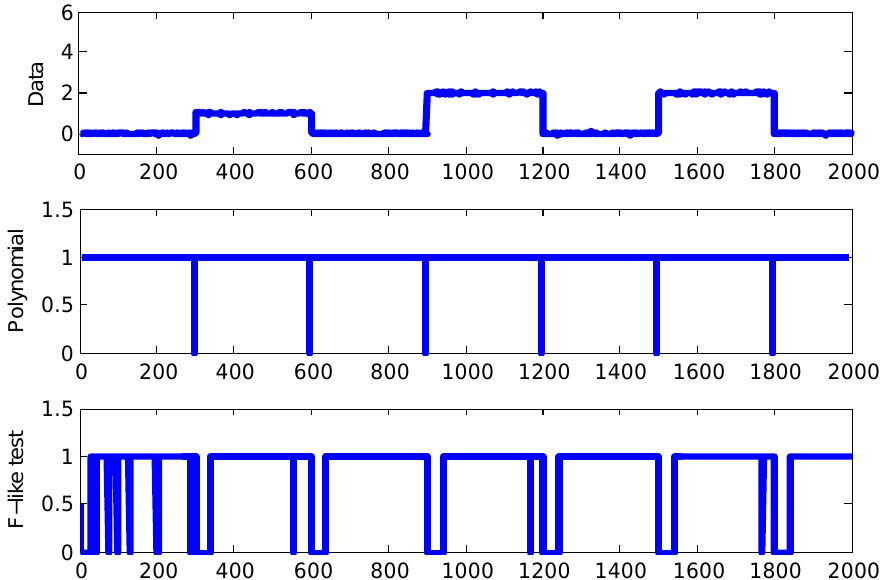
Figure 1. Case 1. Simulated data results with 3% of noise, in which a window of 10 was used for the polynomial technique.